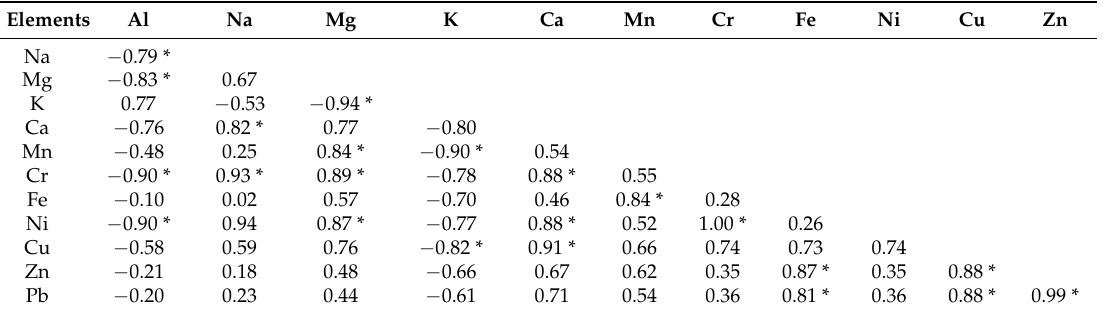
Table 2. Correlation matrix for the metal concentrations in street dust samples.